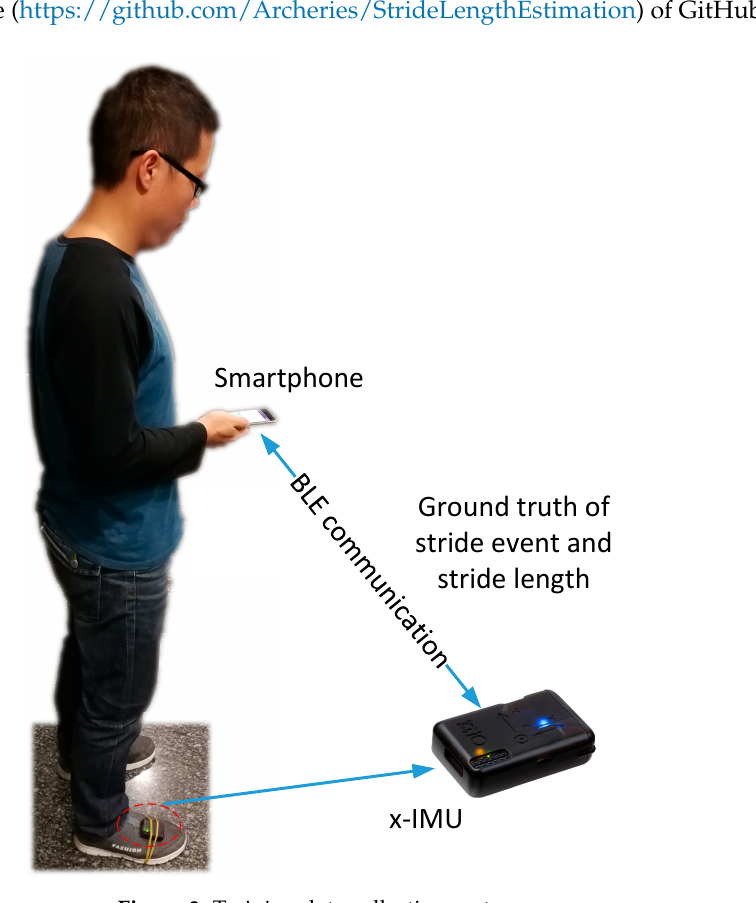
Figure 3. Training data collection system.